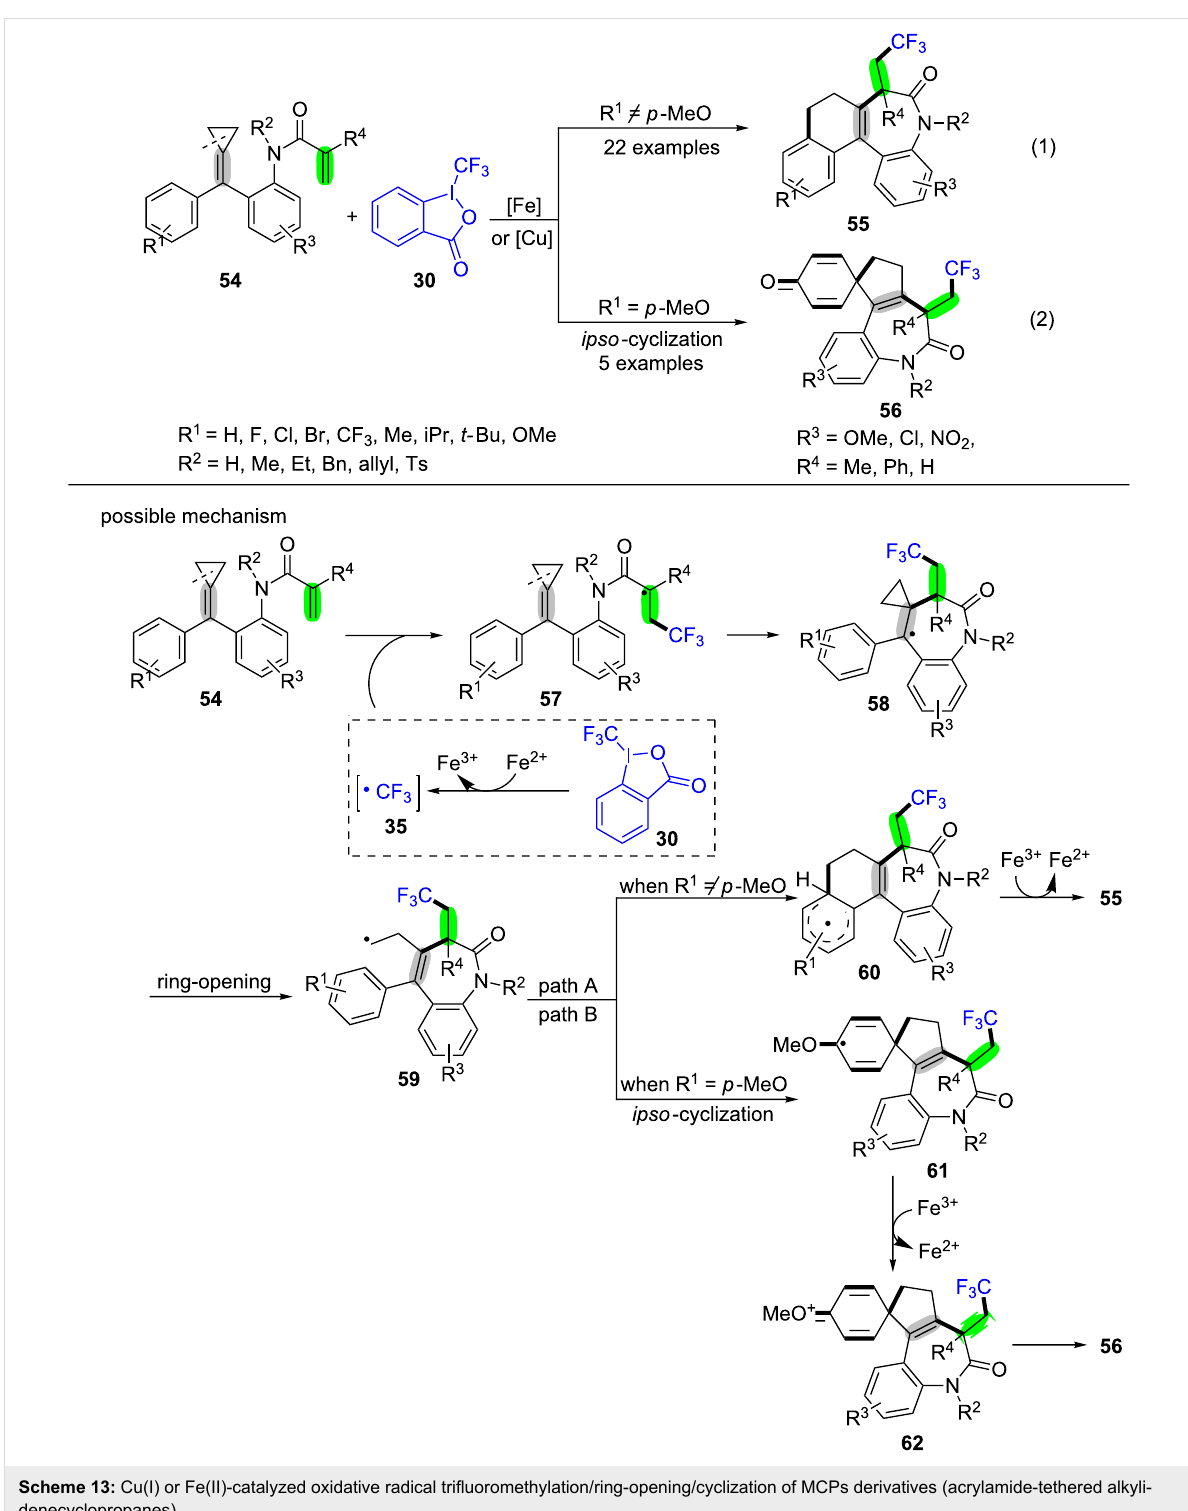
Scheme 13: Cu(I) or Fe(II)-catalyzed oxidative radical trifluoromethylation/ring-opening/cyclization of MCPs derivatives (acrylamide-tethered alkyli- denecyclopropanes).